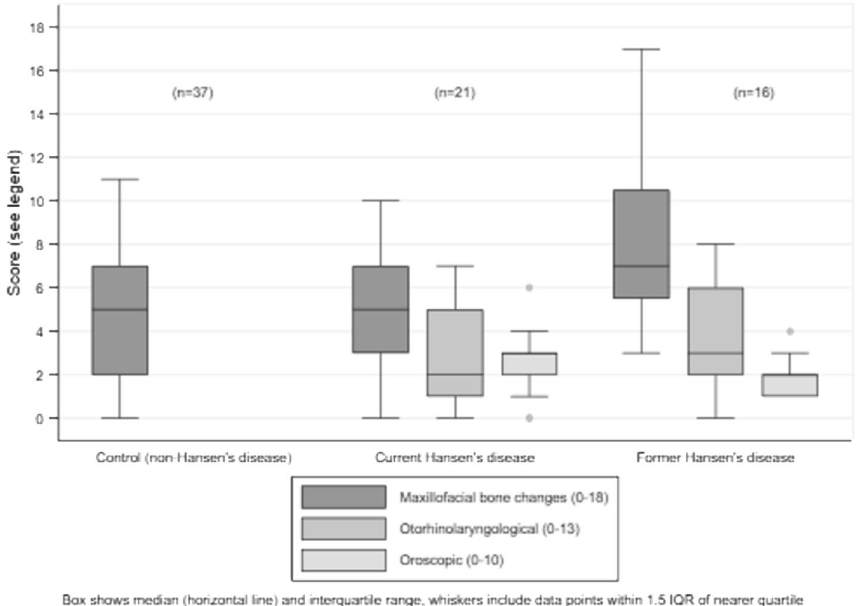
Figure 1. Maxillofacial bone change score and otorhinolaryngological and oroscopic finding scores in controls and in current and former Hansen’s disease